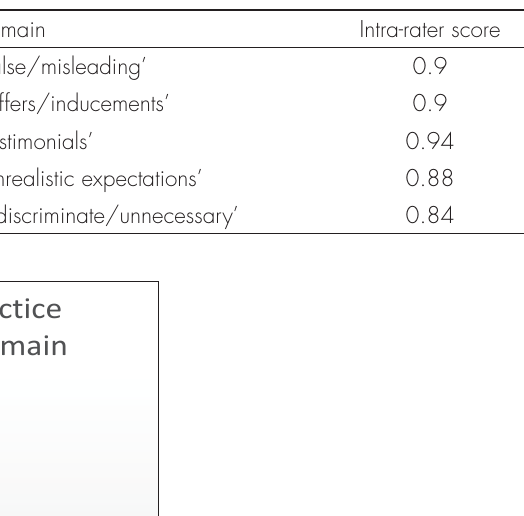
Table II. Intra-rater score for each